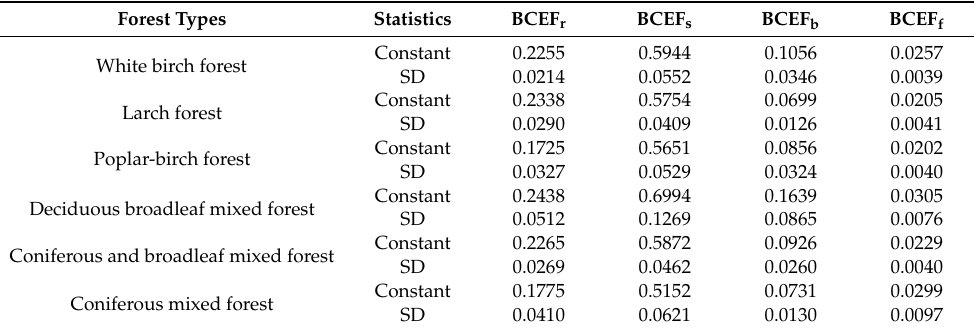
Table 2. Constant (average value) and standard deviation (SD) of biomass expansion and conversion factors (BCEFs) at the stand level (Mg · m − 3 ) for the six forest types in the Eastern Da Xing’an Mountains, Northeast